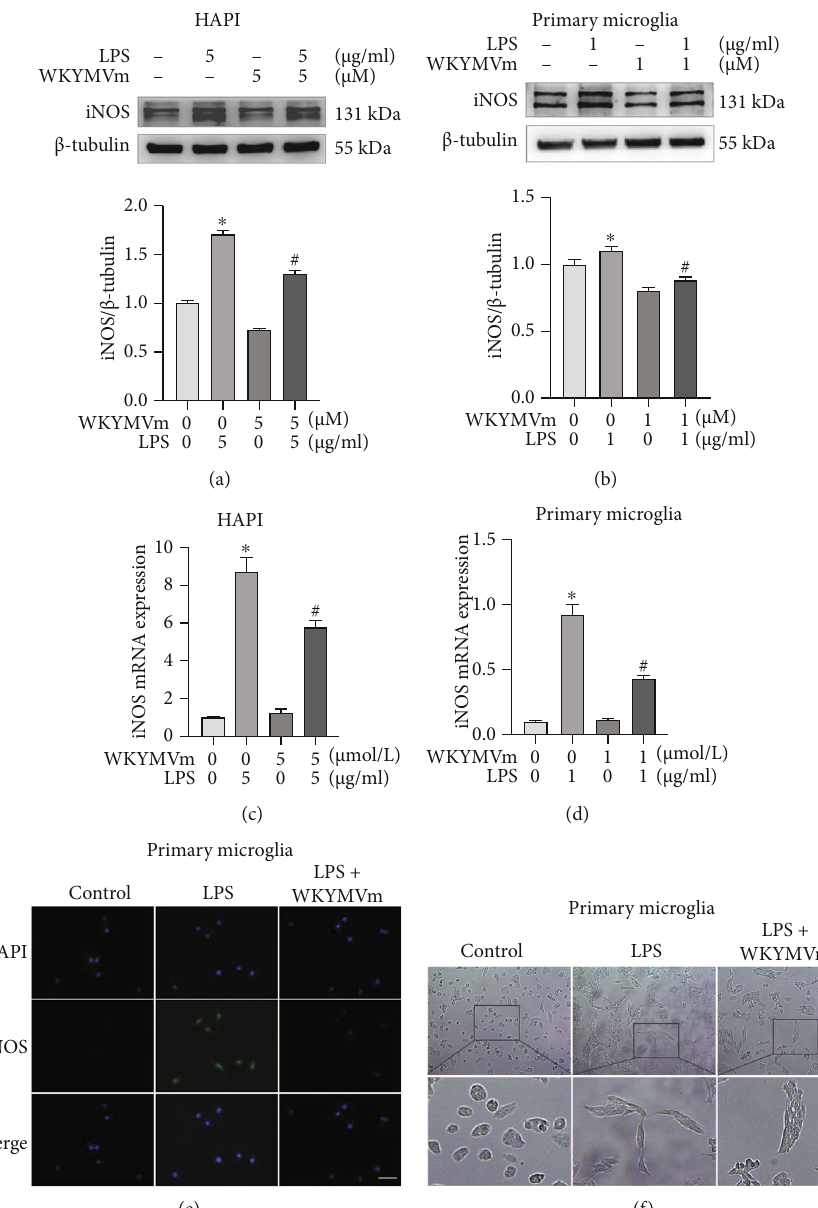
Figure 4: WKYMVm inhibited M1 microglial polarization. iNOS is one of the markers of M1 microglial cells. (a, b) Western blots and quantitative data for iNOS protein in HAPI microglia and primary microglia from di ff erent groups. (c, d) The expression of iNOS mRNA in HAPI microglia and primary microglia from each group was detected by RT-PCR assay. (e) Immuno fl uorescence staining for iNOS in primary microglia from di ff erent groups. Scale bar: 50 μ m. (f) Morphological results of primary microglia treated with LPS or WKYMVm. Scale bar: 100 μ m. ∗ p < 0 : 05 vs. the control group; # p < 0 : 05 vs. the LPS